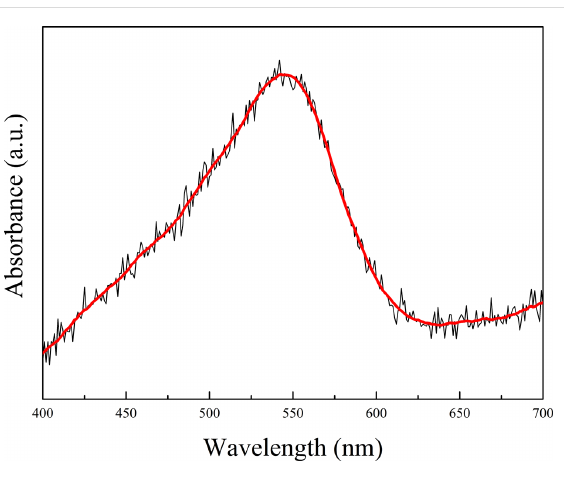
Figure 10: Absorbance spectra recorded for a 2.8 nm Au film on a Si(111) substrate annealed at 550 °C for 15 min.